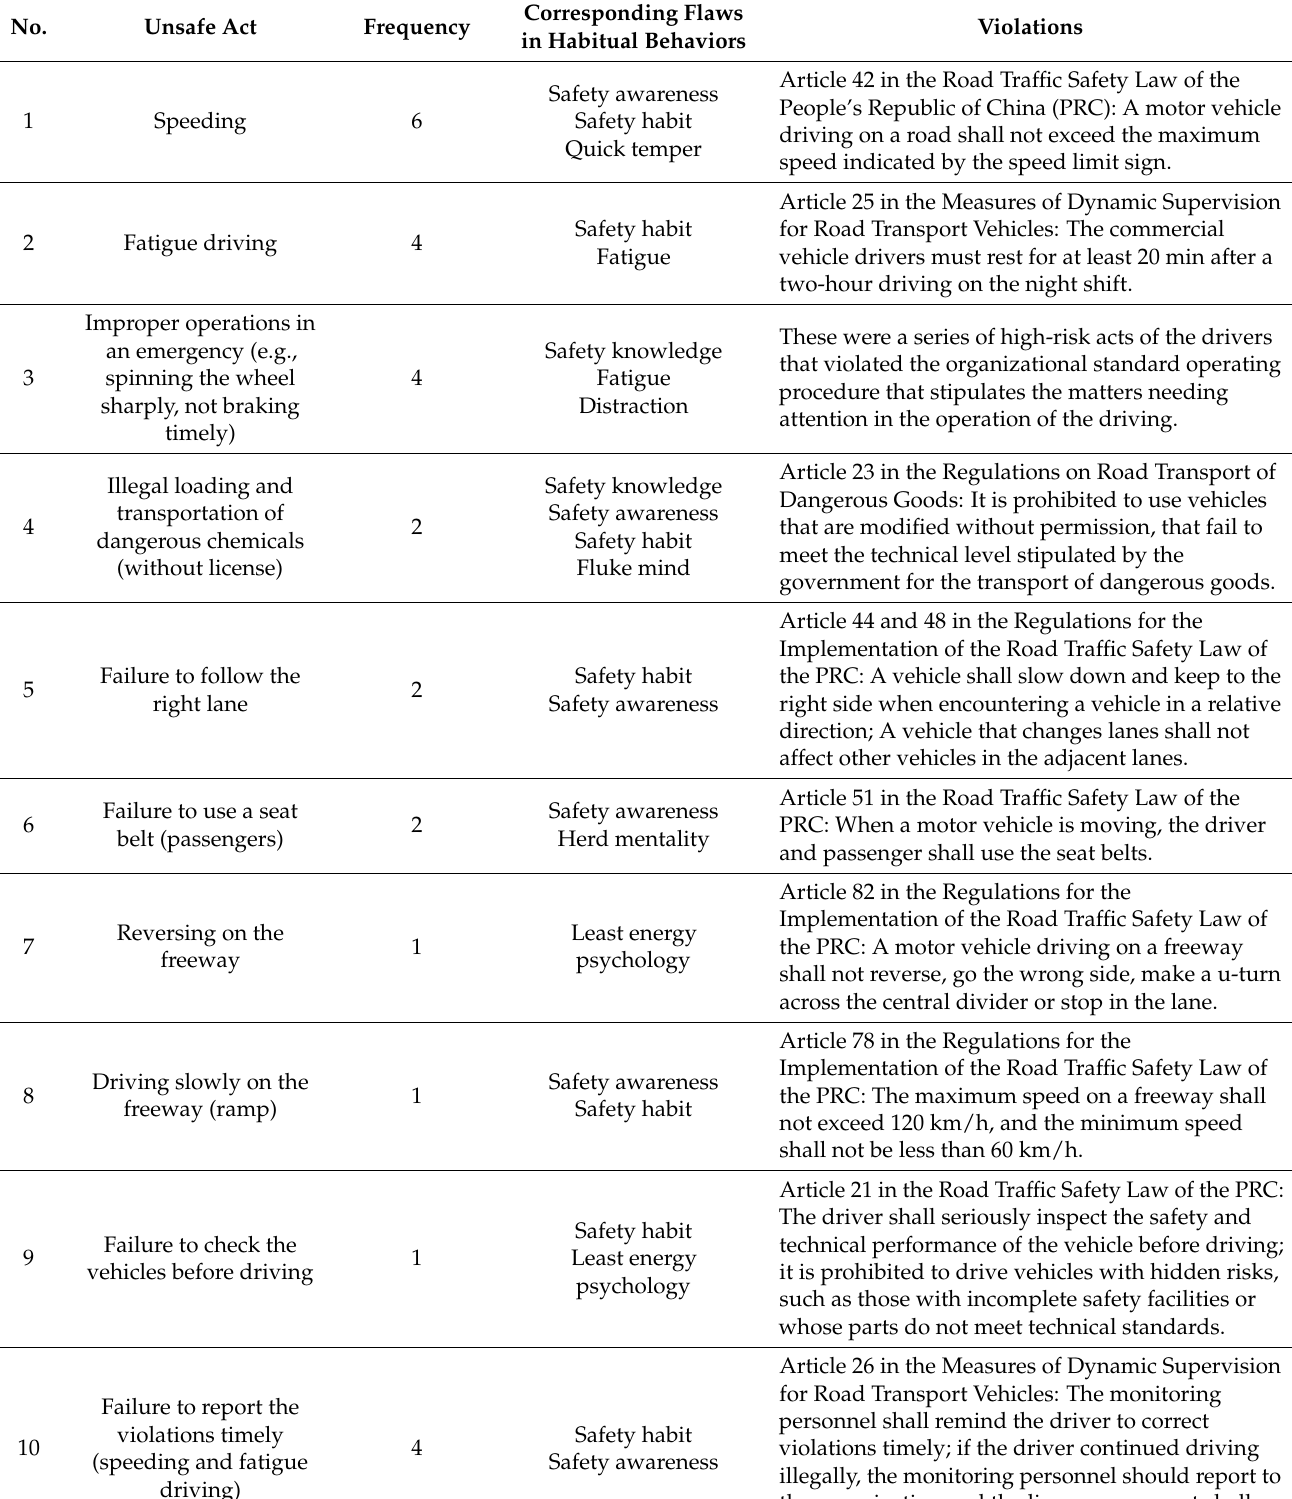
Table 4. Individual factors related to the commercial vehicle